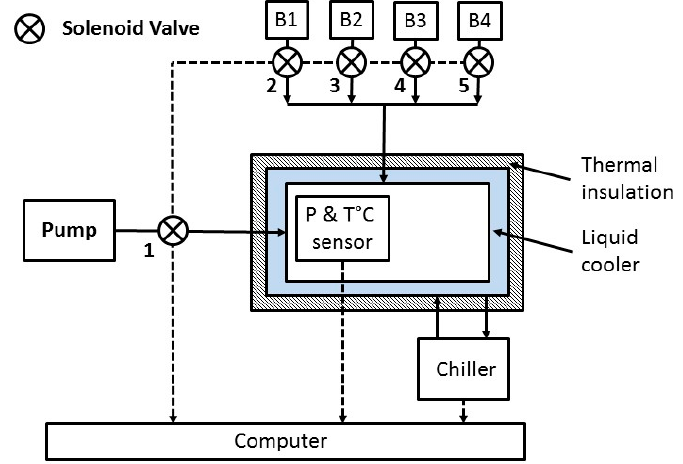
Figure 4. Atmospheric enclosure schematic diagram showing the thermal insulation and liquid cooler layers as well as the different elements connected and controlled by a single